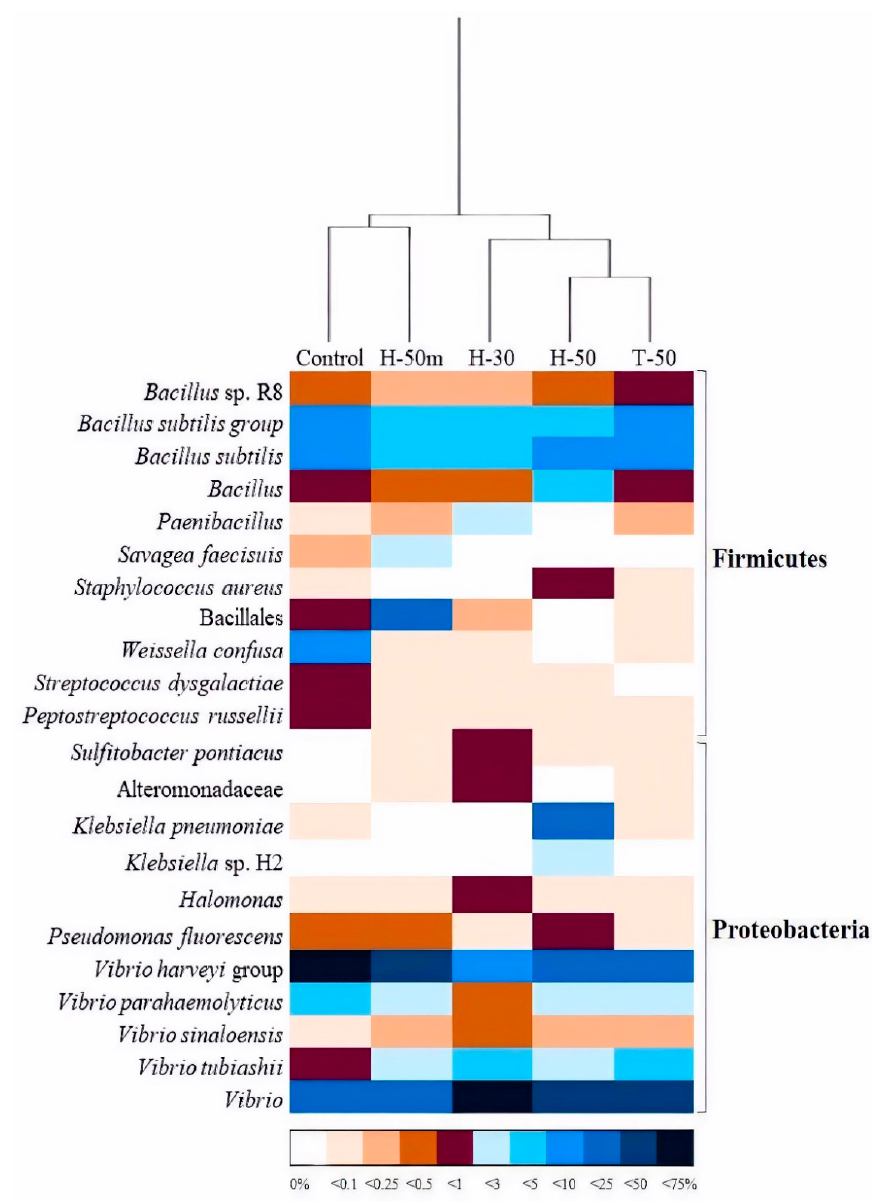
Figure 3. Heatmap representing the distribution, expressed as a percentage, of OTUs within samples and a dendrogram showing the relationships between treatments based on a restricted microbial community.